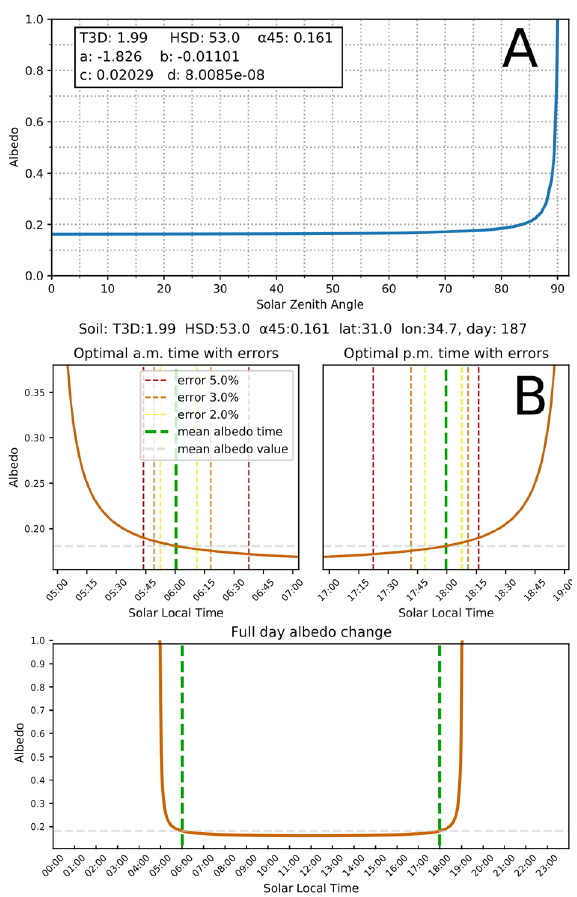
Fig. 5. Visualisation of the results. (A) Location- agnostic soil-surface albedo model produced by the soil surface albedo module ( Calcic Xerosol ); (B) Diurnal a variation produced by the diurnal albedo module ( Calcic Xerosol)